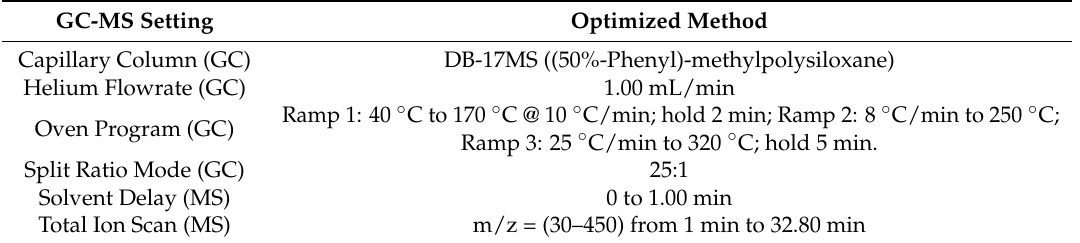
GC-MS operating parameters used for the qualitative emissions analysis results presented